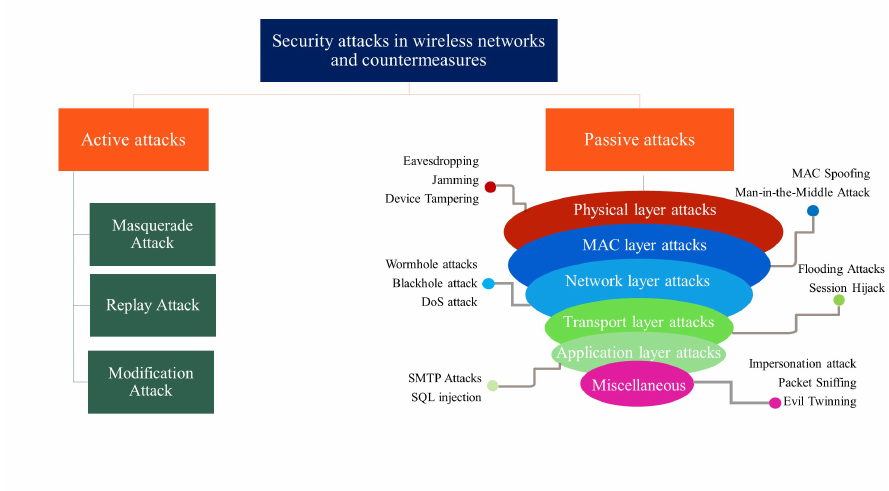
Figure 7. The proposed taxonomy for blockchain-enabled wireless